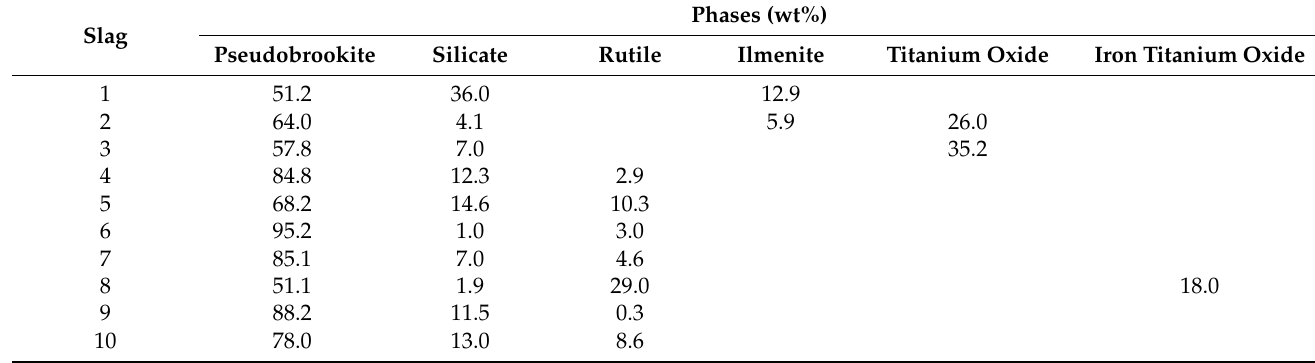
Figure 5. X-ray powder diffraction (XRD) patterns of three synthetic slags. Table 3. Phases in weight (percentage) detected by X-ray powder diffraction (XRD) for each sample using the Rietfeld refinement.